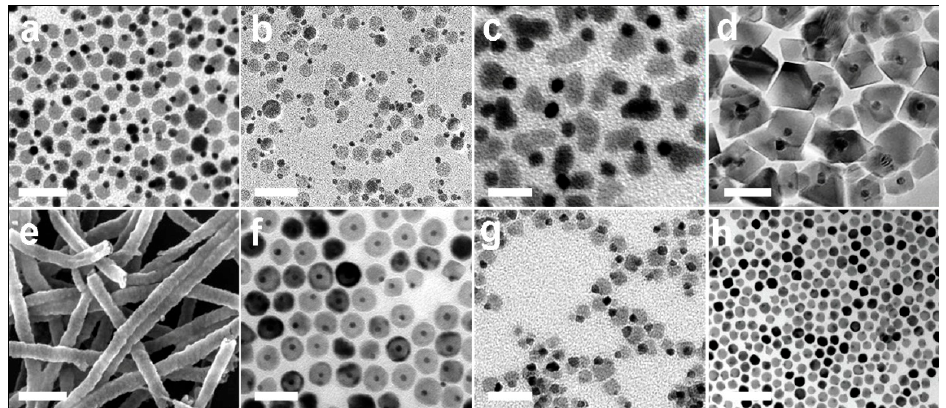
Figure 2. Microscopic images of different metallic-nonmetallic heterodimers. TEM image of Fe 3 O 4 -Au heterodimers, scale bar: 40 nm, reproduced with permission from [110], copyright (2015) American Chemical Society ( a ), TEM image of Fe 3 O 4 -Ag heterodimers, scale bar: 40 nm, with permission from [111], copyright (2017) Elsevier ( b ), TEM image of Fe 3 O 4 -Pt heterodimers, scale bar: 30 nm, with permission from [112], copyright (2013) American Chemical Society ( c ), TEM image of Fe 3 O 4 -Pd heterodimers, scale bar: 30 nm, with permission from [113], copyright (2011) Royal Society of Chemistry ( d ), SEM image of CoFe 2 O 4 -Pd heterodimers, scale bar: 300 nm, with permission from [117], copyright (2016) Royal Society of Chemistry ( e ), TEM image of MnO-Au heterodimers, scale bar: 40 nm, with permission from [121], copyright (2014) American Chemical Society ( f ), TEM image of FePt-CdS heterodimers, scale bar: 40 nm, with permission from [123], copyright (2009) American Chemical Society ( g ), and TEM image of CdO-FePt heterodimers, scale bar: 100 nm, with permission from [73], copyright (2014) American Chemical Society ( h